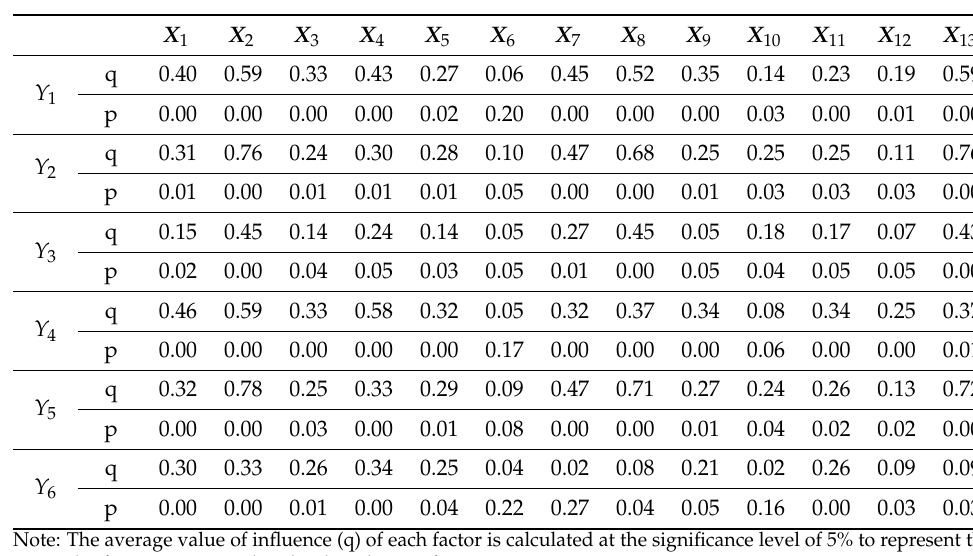
Table 3. Analysis of factor detector.